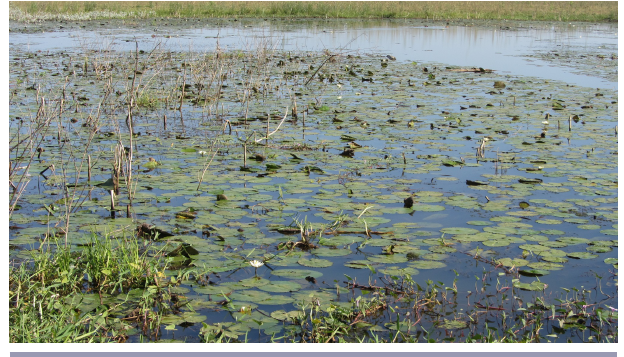
Fig. 7. Water lilies in a